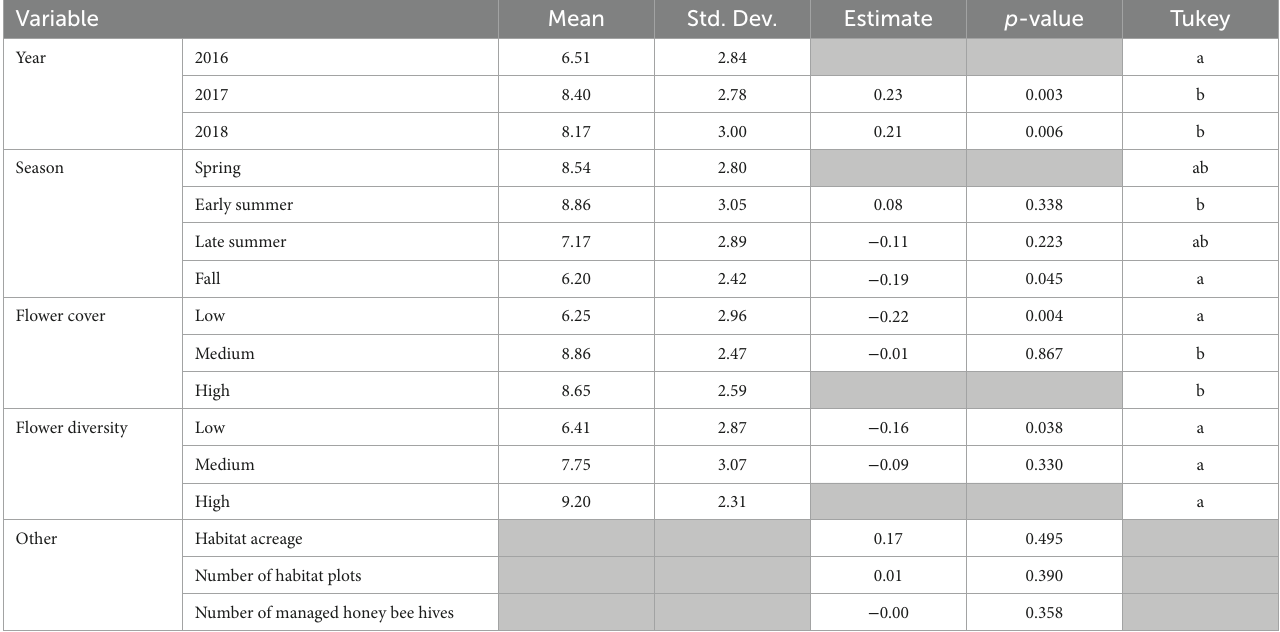
TABLE 3 Output from generalized linear mixed model and Tukey’s post-hoc analysis with genus richness as the response with a Poisson distribution. Variable Mean Std. Dev. Estimate p -value